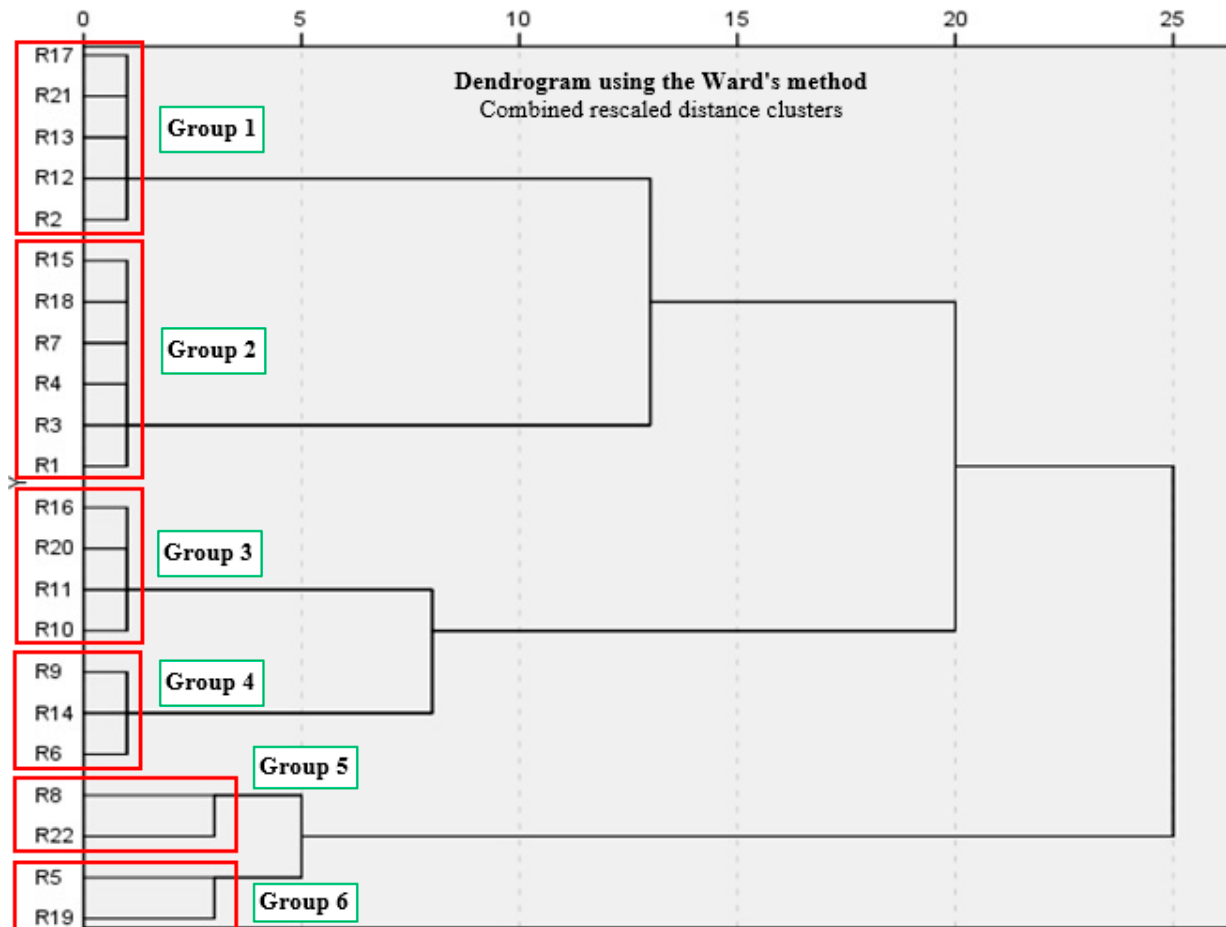
Figure 2. Dendrogram from the Hierarchical Cluster Analysis. Table 2. Allocation of the respondents based on educational level, experience and